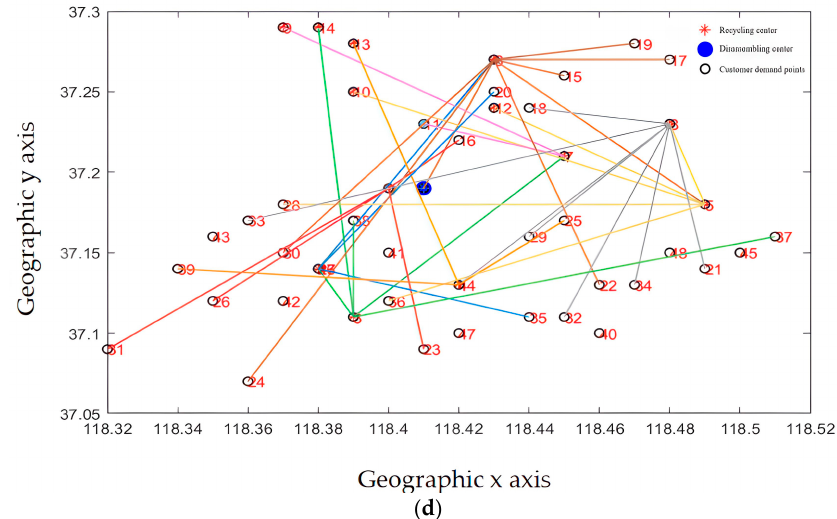
Figure 13. ( a ) The recycling center is responsible for the distribution of subordinate customer demand points (fewer demand points). ( b ) The recycling center is responsible for the distribution of subordinate customer demand points (responsible for demand points generally). ( c ) The recycling center is responsible for the distribution of subordinate customer demand points (more demand points). ( d ) The complete recycling center is responsible for the distribution of customer require- ments points.